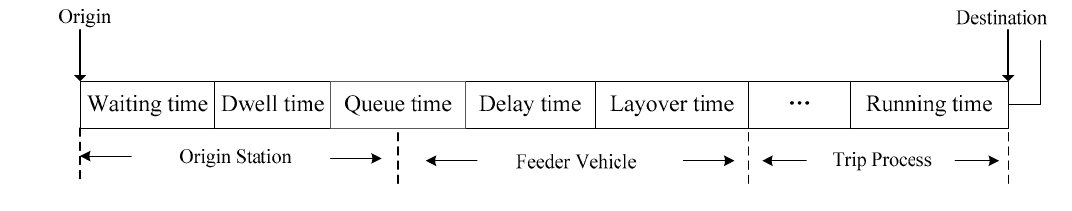
Figure 1. Components of total travel time.